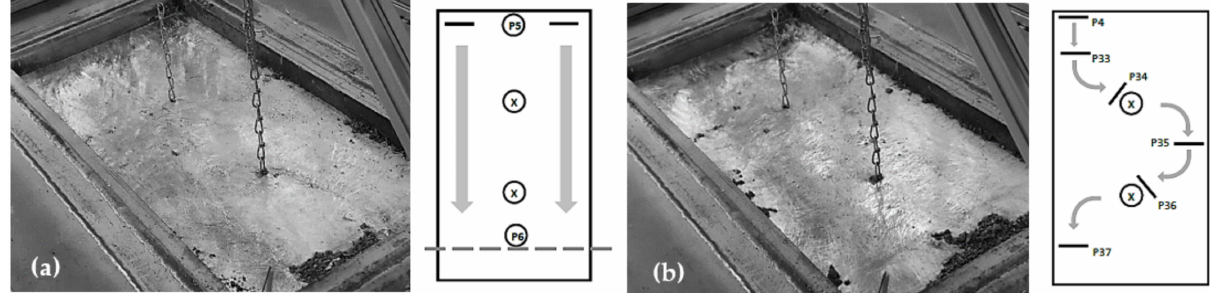
Figure 8. Task-related efficiency of the gas-based skimming system with skimming rate of 0.05 m/s: ( a ) Two-step sinusoidal movement; ( b ) Linear movement.